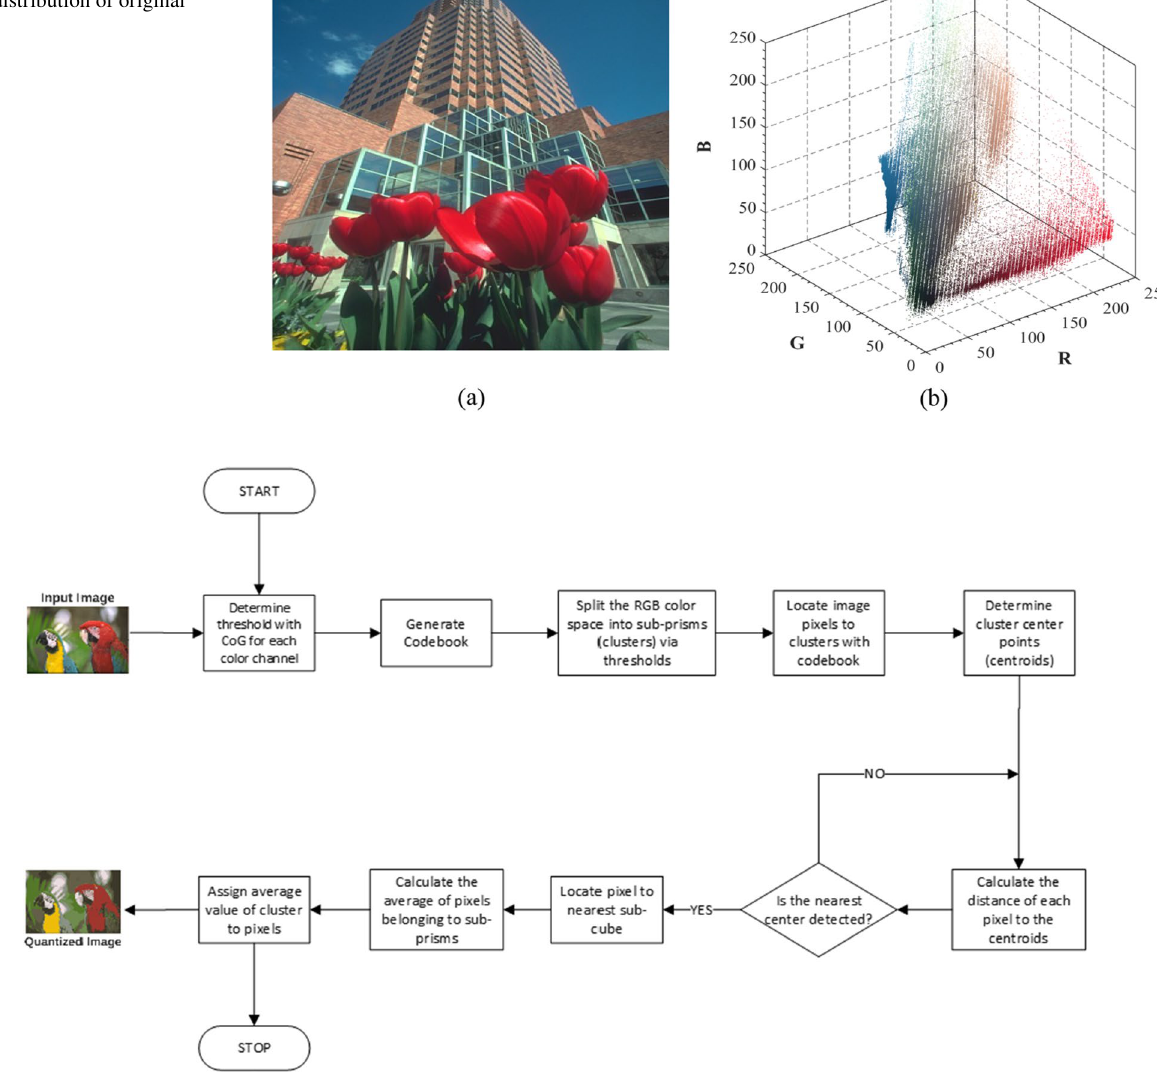
Fig. 2 Flowchart of proposed